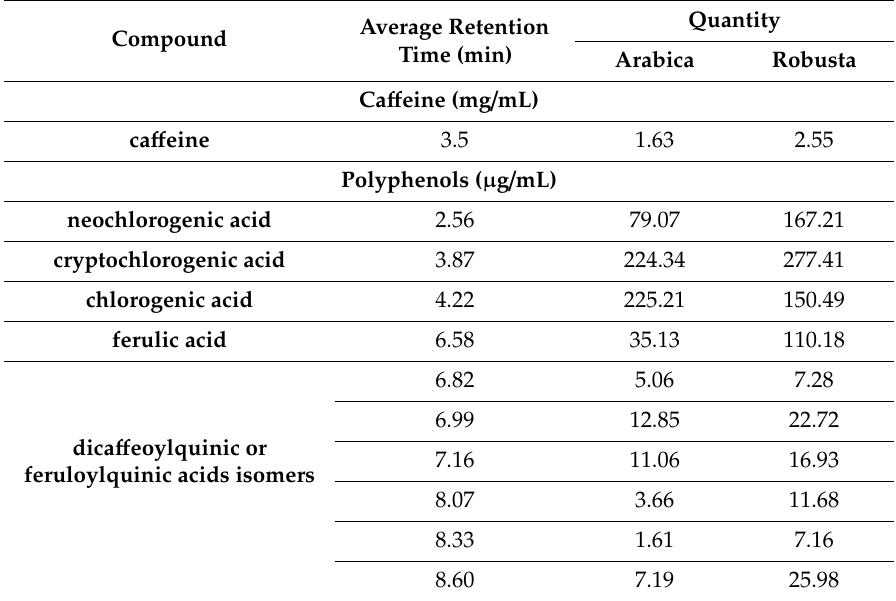
Table 1. Average ca ff eine and polyphenol content in Arabica and Robusta infusions.